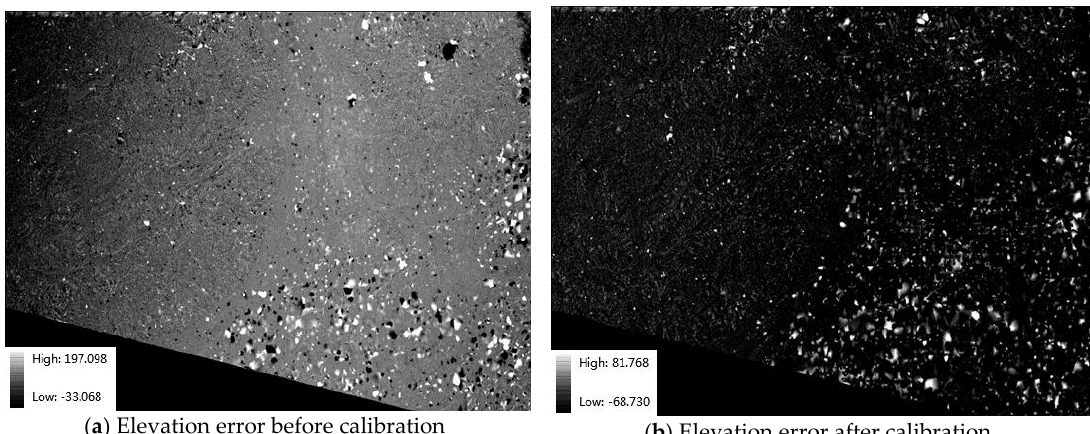
error statistics are shown in Table 6. Before calibration, there is one peak (120 m) in the statistical plot, which results in a mean elevation error of 95.927 m and an RMS error of 103.850 m. The systematic